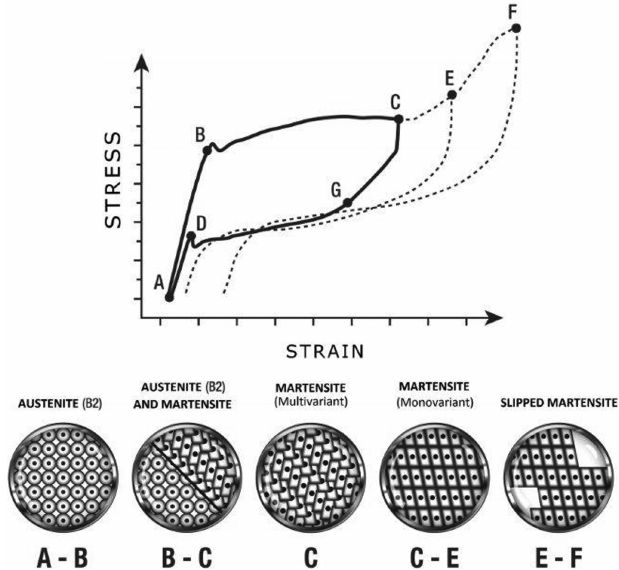
Figure 2. Representative tensile stress-strain curve of the archwires; the labeled points correspond to phase